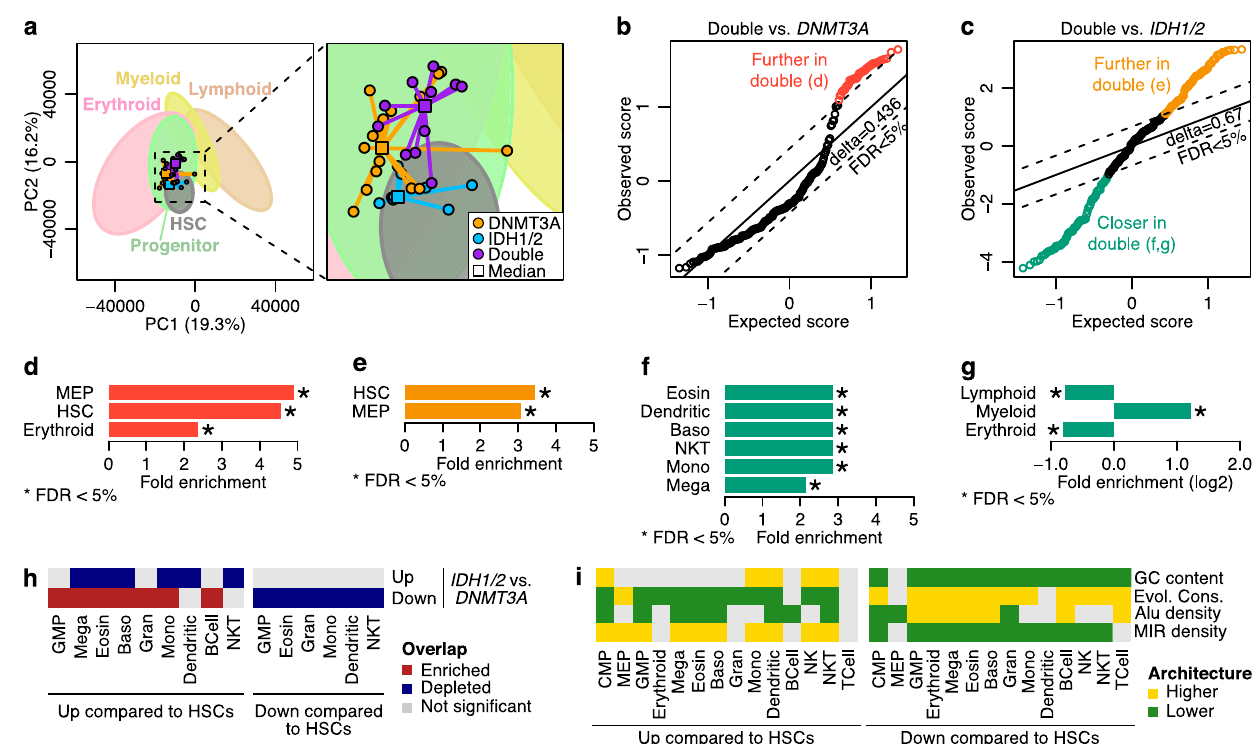
Fig. 6 | AML subtype differences can be projected on MIR-biased expression trajectories of normal hematopoiesis. a PCA plot of the ranked-normalized normal and AMLexpression pro fi les. For simplicity,onlyAML samples areplotted, while ellipses are fi tted to show the space occupied by each lineage. For each AML subtype, the median projection per principal component was calculated and plotted as a square. The exact coordinates of each sample are included in Sup- plementary Data 6. Signi fi cance Analysis of Microarrays (SAM) plots showing the statistically signi fi cant differences in the distances between Double and DNMT3A ( b ) or IDH mutant samples ( c ). Each circle represents a normal sample. If the dif- ference between the observed score and the expected, as calculated after random permutations, is larger than the threshold delta corresponding to an FDR of 5%, thenthedistanceofthe DNMT3A mutantsamples( b )orthe IDH mutantsamples( c ) is signi fi cantly different than the distance of the double mutants. Samples that exceed this threshold are colored orange, green or yellow. d – g Enrichment in cell